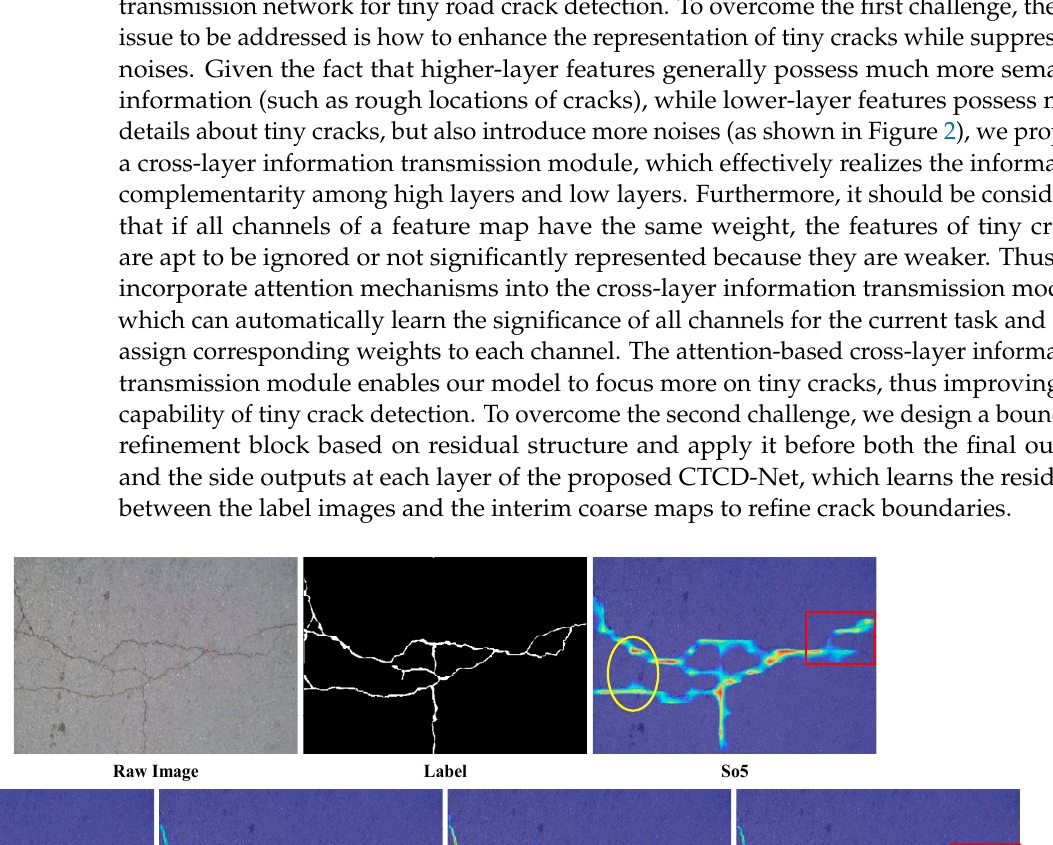
Figure 1. Visual presentation of the two challenges in crack detection: poor performance and com- pleteness in extracting tiny cracks (red boxes); rougher and thicker crack boundaries (green boxes).